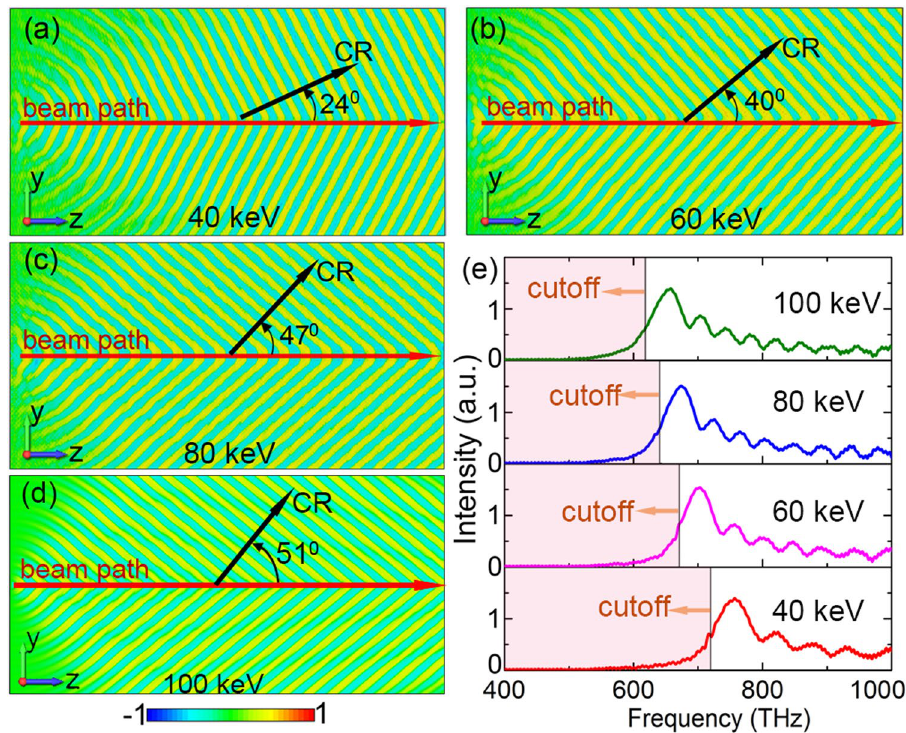
Figure 3. ( a – d ) are contour maps of the E z field on the surface of the nano-film respectively for cases with beam energies of 40 keV, 60 keV, 80 keV, and 100 keV. ( e ) The detected